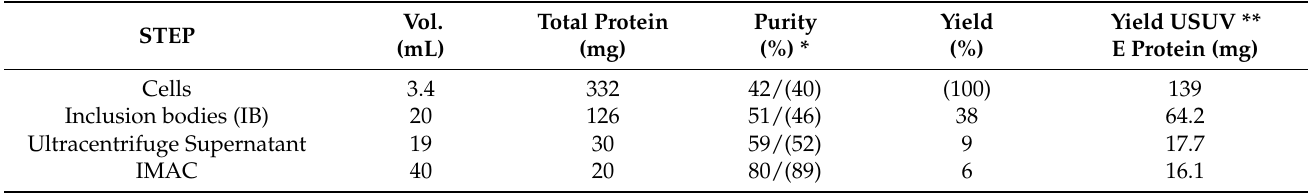
Table 1. Purification table for USUV E protein.